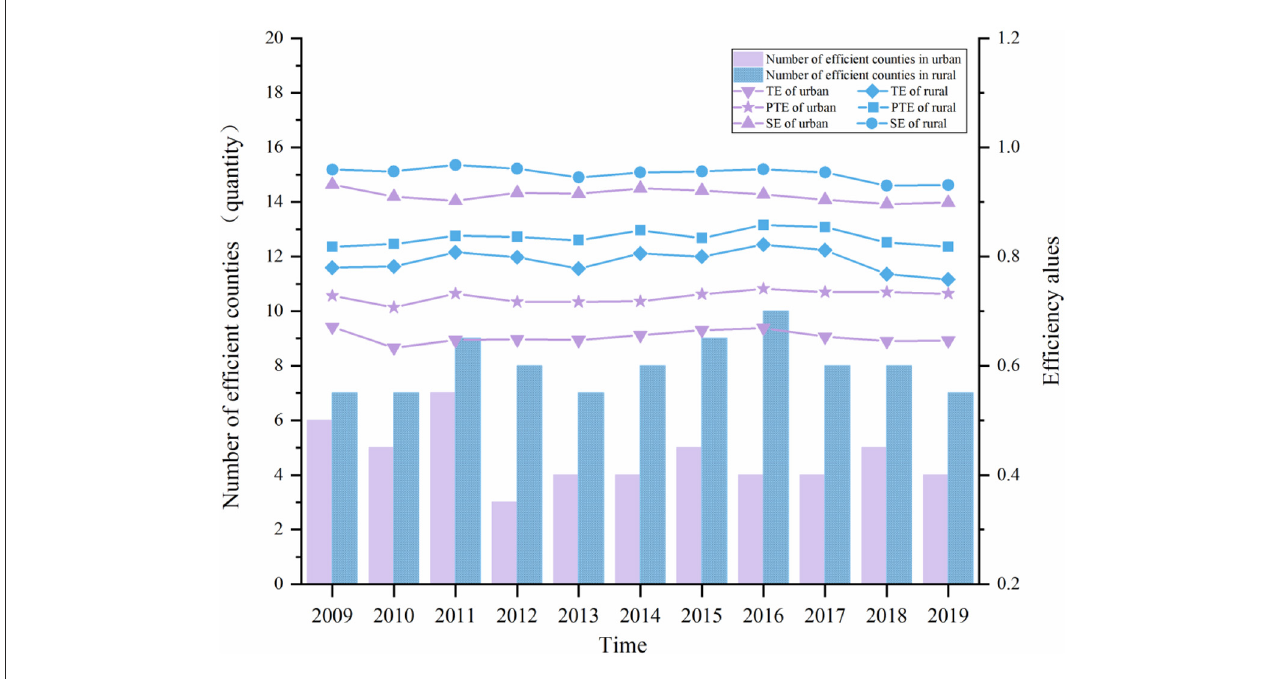
FIGURE1 The DEA analysis for PHCIs,